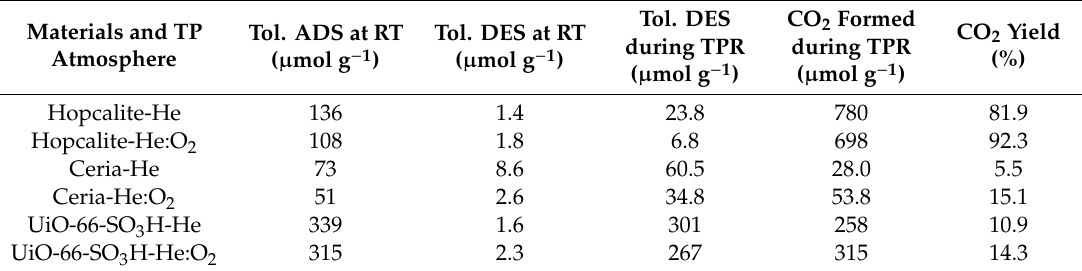
Table 4. Comparison of materials during toluene (100 ppm) adsorption followed by temperature programmed desorption in inert and oxidizing